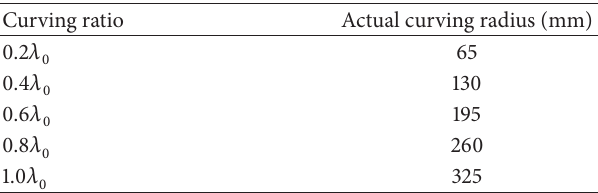
Table 2: Curving ratio and actual curving radius. Curving ratio Actual curving radius